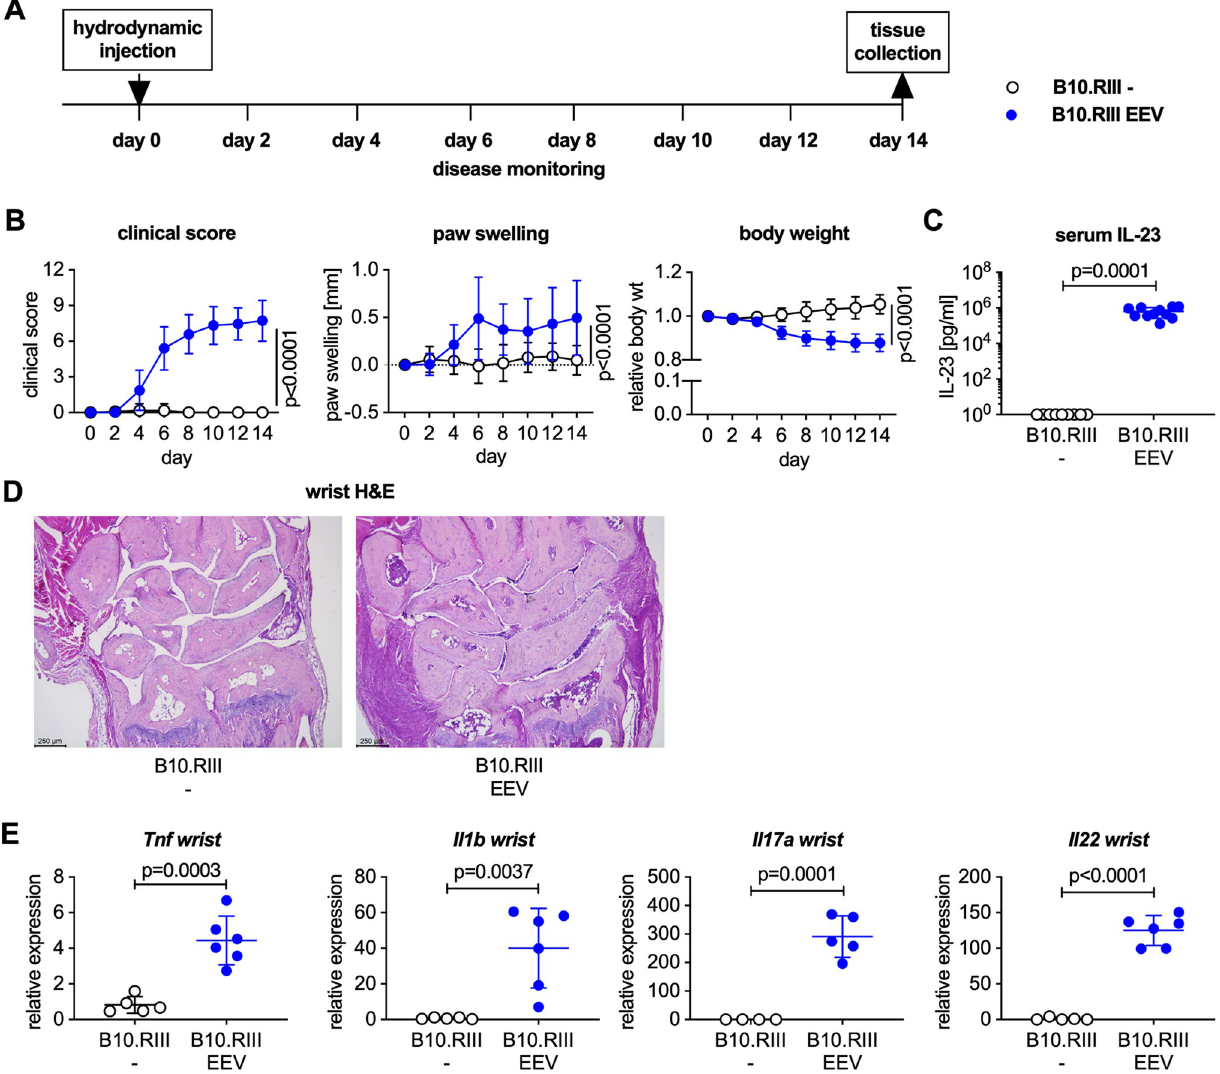
Fig 1. Male B10.RIII mice develop arthritis after hydrodynamic injection of IL-23 EEV. (A) Experimental layout for IL-23 EEV-induced arthritis experiments. (B) 8–12 week-old male B10.RIII mice received 500 ng IL-23 EEV on day 0 via hydrodynamic tail vein injection; control mice received no injection (n = 12–15 mice/group). Clinical score (mean ± SD). Paw swelling (mean ± SD). Body weight (mean ± SD). (C) Serum IL-23 concentrations on day 14 were determined by ELISA (n = 9–11 mice/group). (D) Representative H&E stained sections of day 14 wrists from control and IL-23 EEV injected mice, scale bar 250 μ m. (E) Gene expression analysis in the wrists on day 14 (n = 5–6 mice/group). qPCR data for individual samples were first normalized by Hprt expression and then divided by the mean of the uninjected control group. P values on day 14 were determined by unpaired t-test.